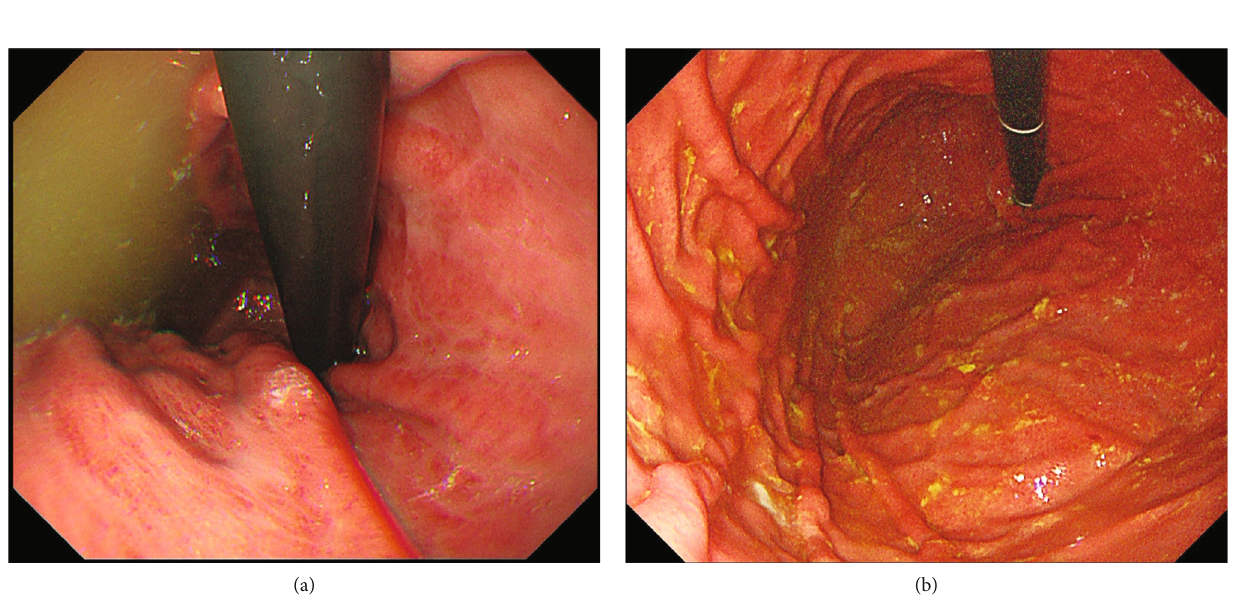
Figure 3: Endoscopic presentation of bile re fl ux gastric. (a): Bile lake; (b): bile